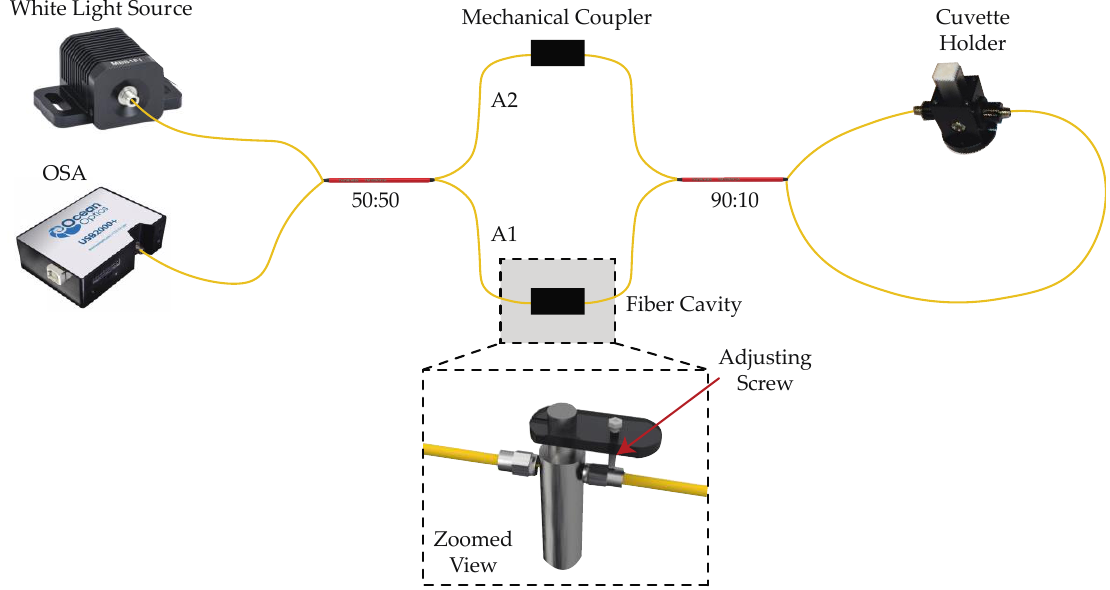
Figure 1. Schematic diagram of the experimental setup. OSA: optical spectrum analyzer.